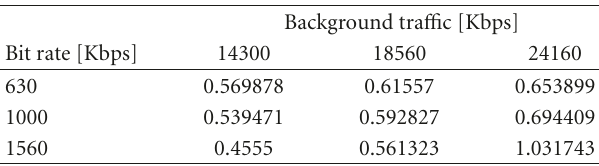
Table 6: VQM Values measured through MSU software, signal power level − 15 dBm.